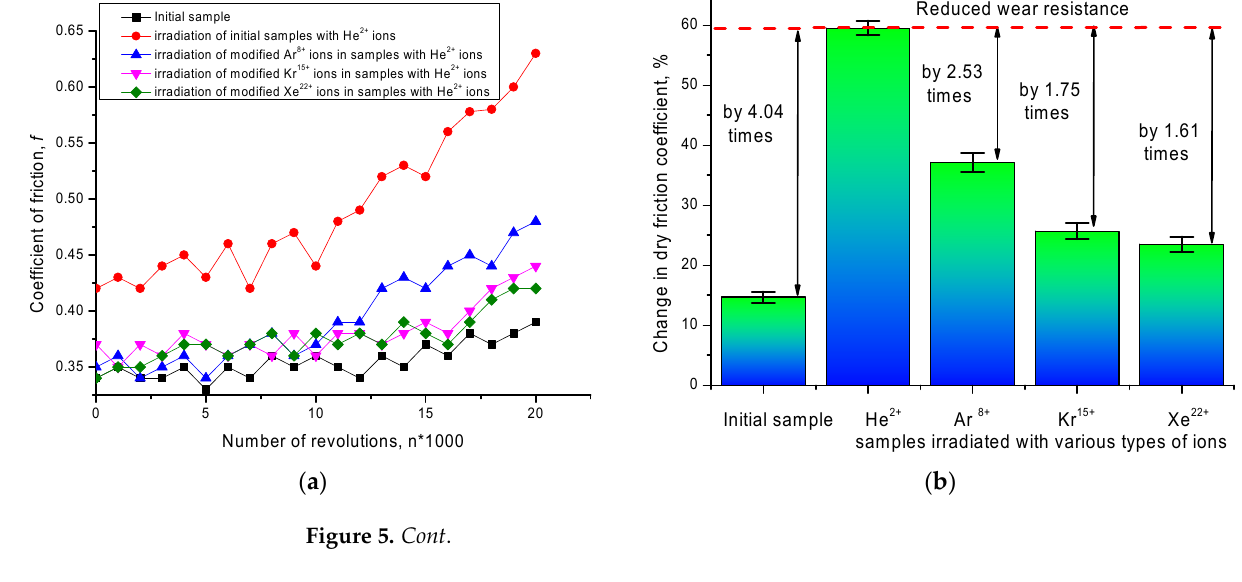
Figure 4. ( a ) Results of changes in ceramic hardness after irradiation with He 2+ ions. ( b ) Results of near-surface layer softening degree and softening resistance change.